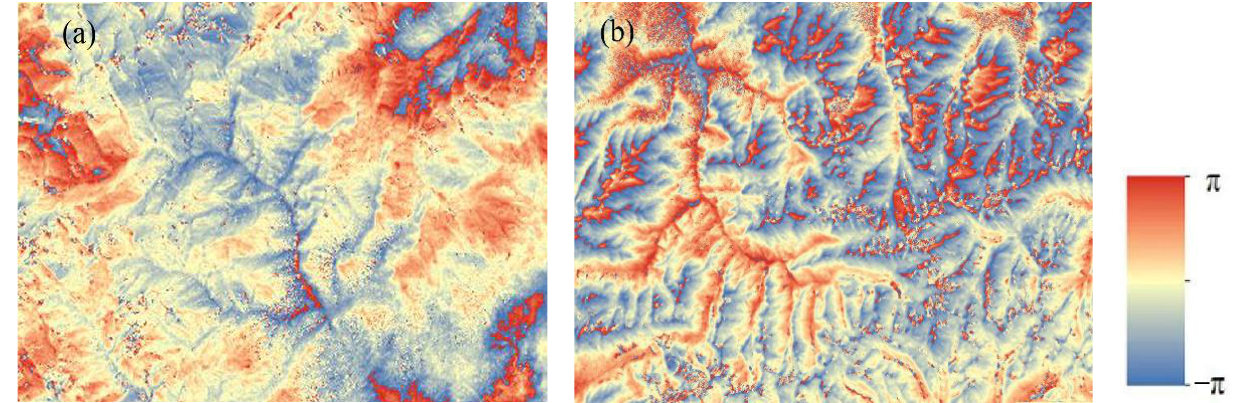
Figure 2. Interferogram after flattening. ( a ) the ascending Sentinel-1 pairs in 2017-06-11 – 2017-06-23; ( b ) the descending Sentinel-1 pairs in 2017-06-11 – 2017-06-23.